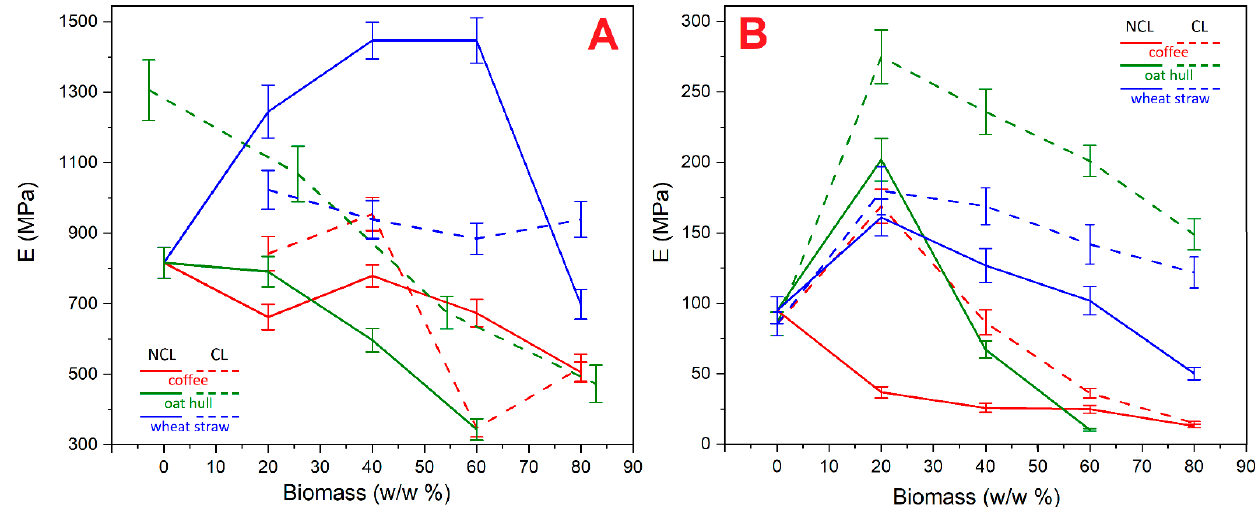
Figure 4. Comparative charts of Young’s moduli (E) vs. biomass content (%) for the crosslinked (CL) and non-crosslinked (NCL) composite pellets in the dry ( A ) and hydrated ( B ) states. In contrast to the variation in Young’s modulus of pellets in their dry state (cf. Table 3), crosslinking improved elastic modulus over their NCL counterparts after hydration (cf. Table 4).